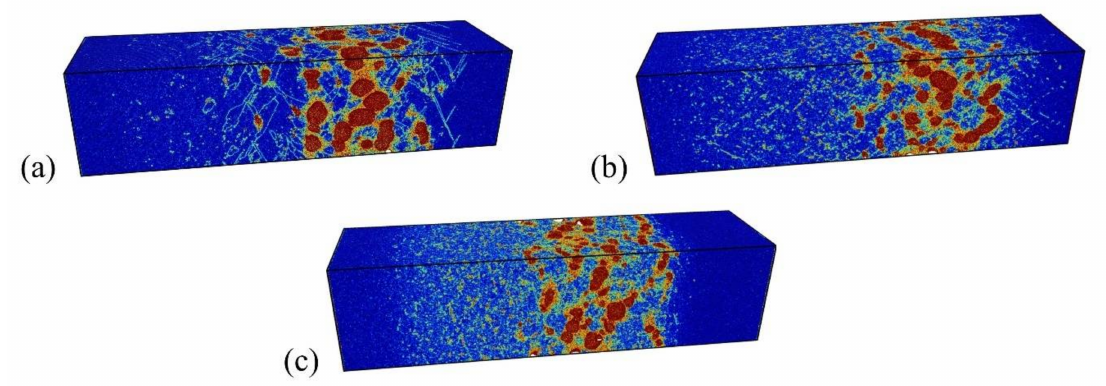
Figure 4. Snapshots of single-crystal Ta along ( a ) (001), ( b ) (110), and ( c ) (111) orientation at 50 ps. The atoms are colored based on centrosymmetric parameters